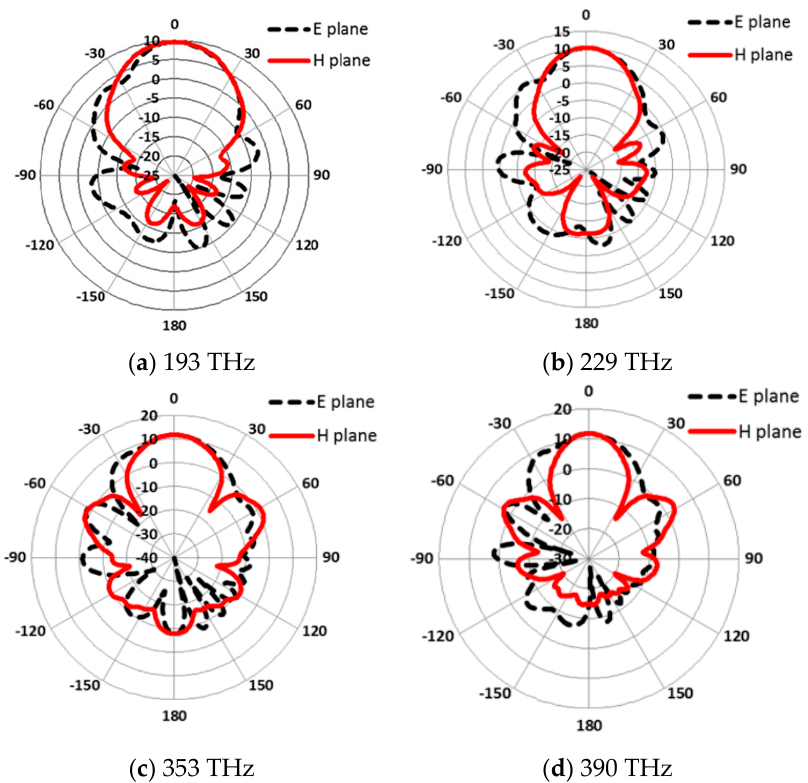
Figure 15. Radiation efficiency for the 2 × 1 antenna array.